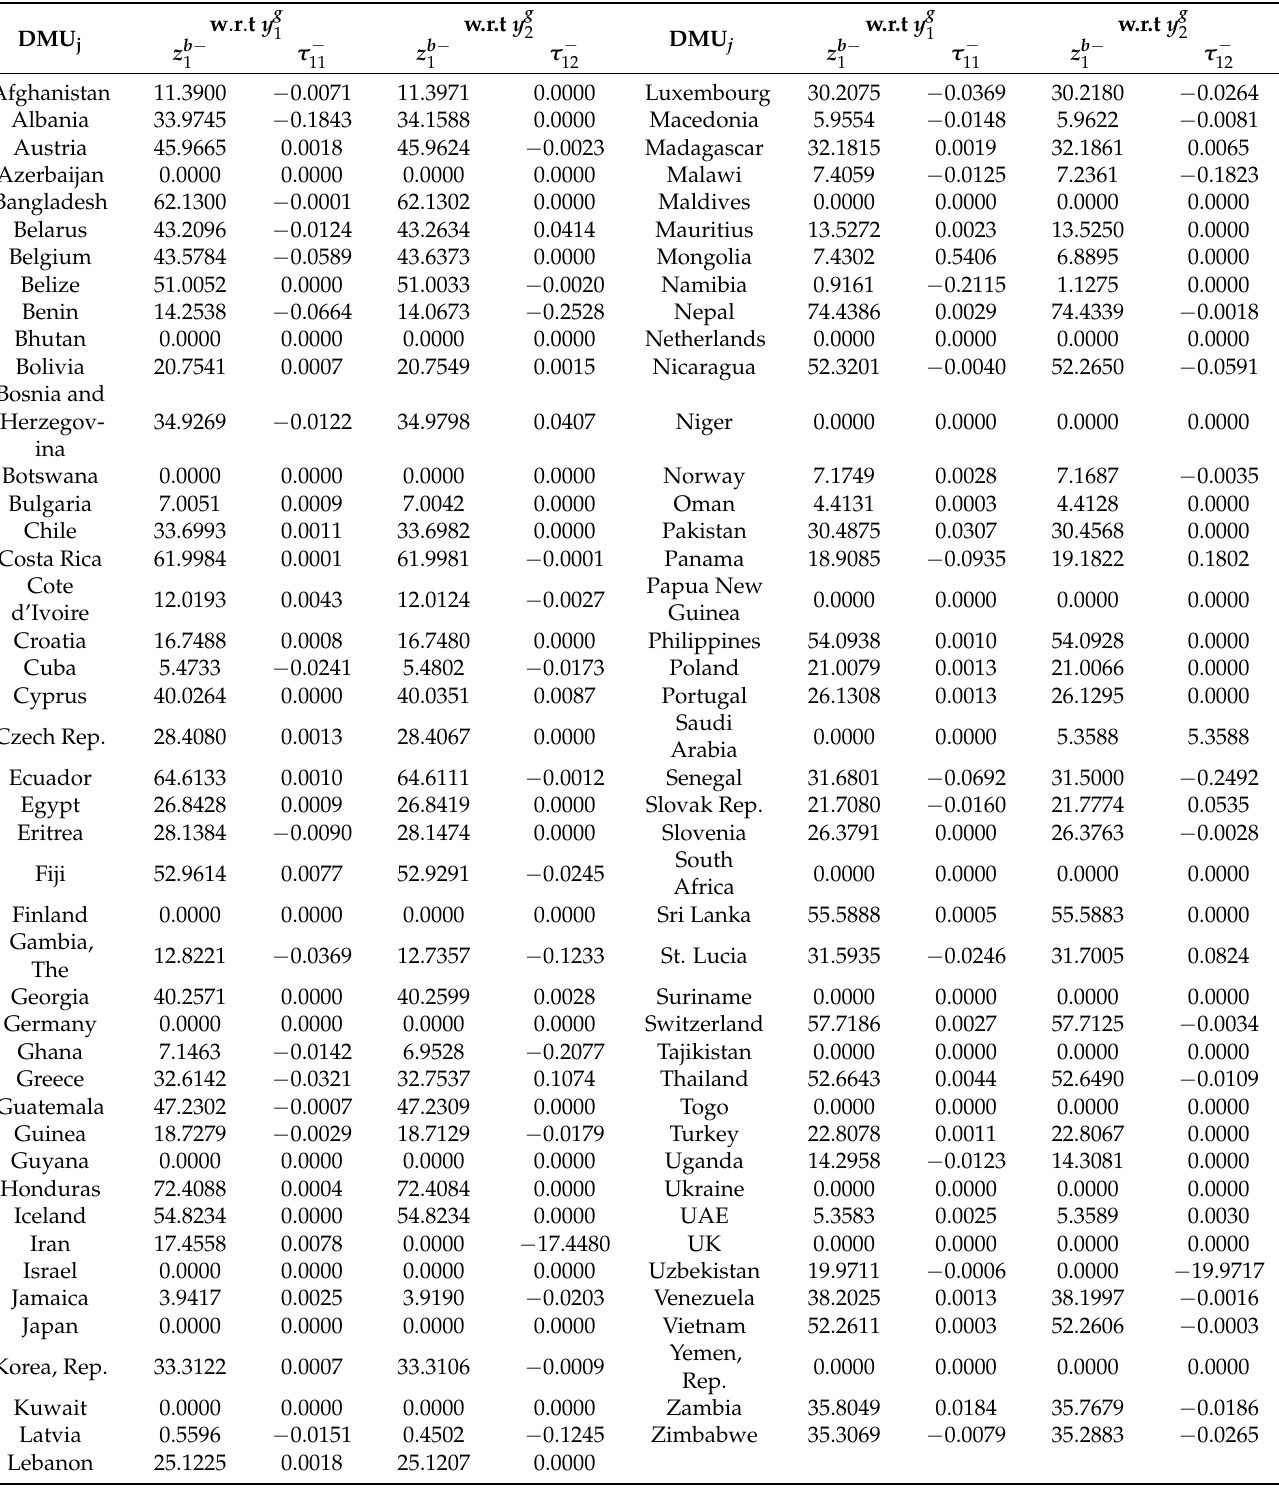
) when h = − 0.5 and d = (1, 1